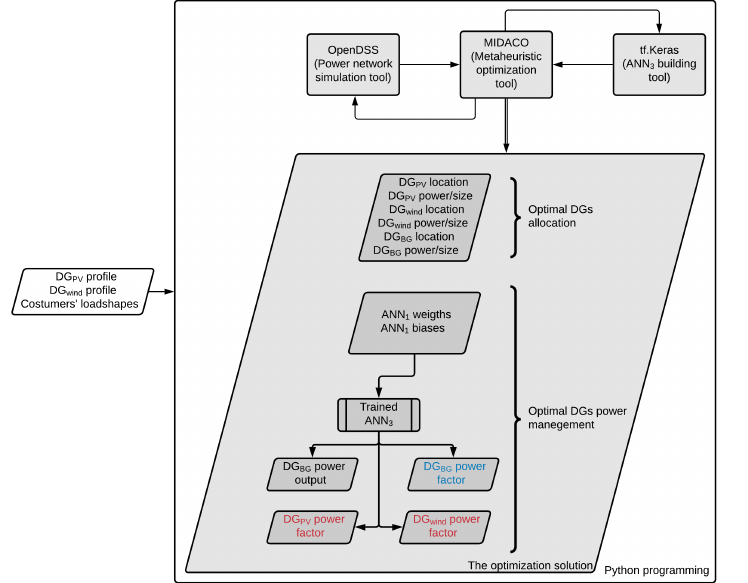
Figure 3. The framework used for Opt 3 optimization scenarios.